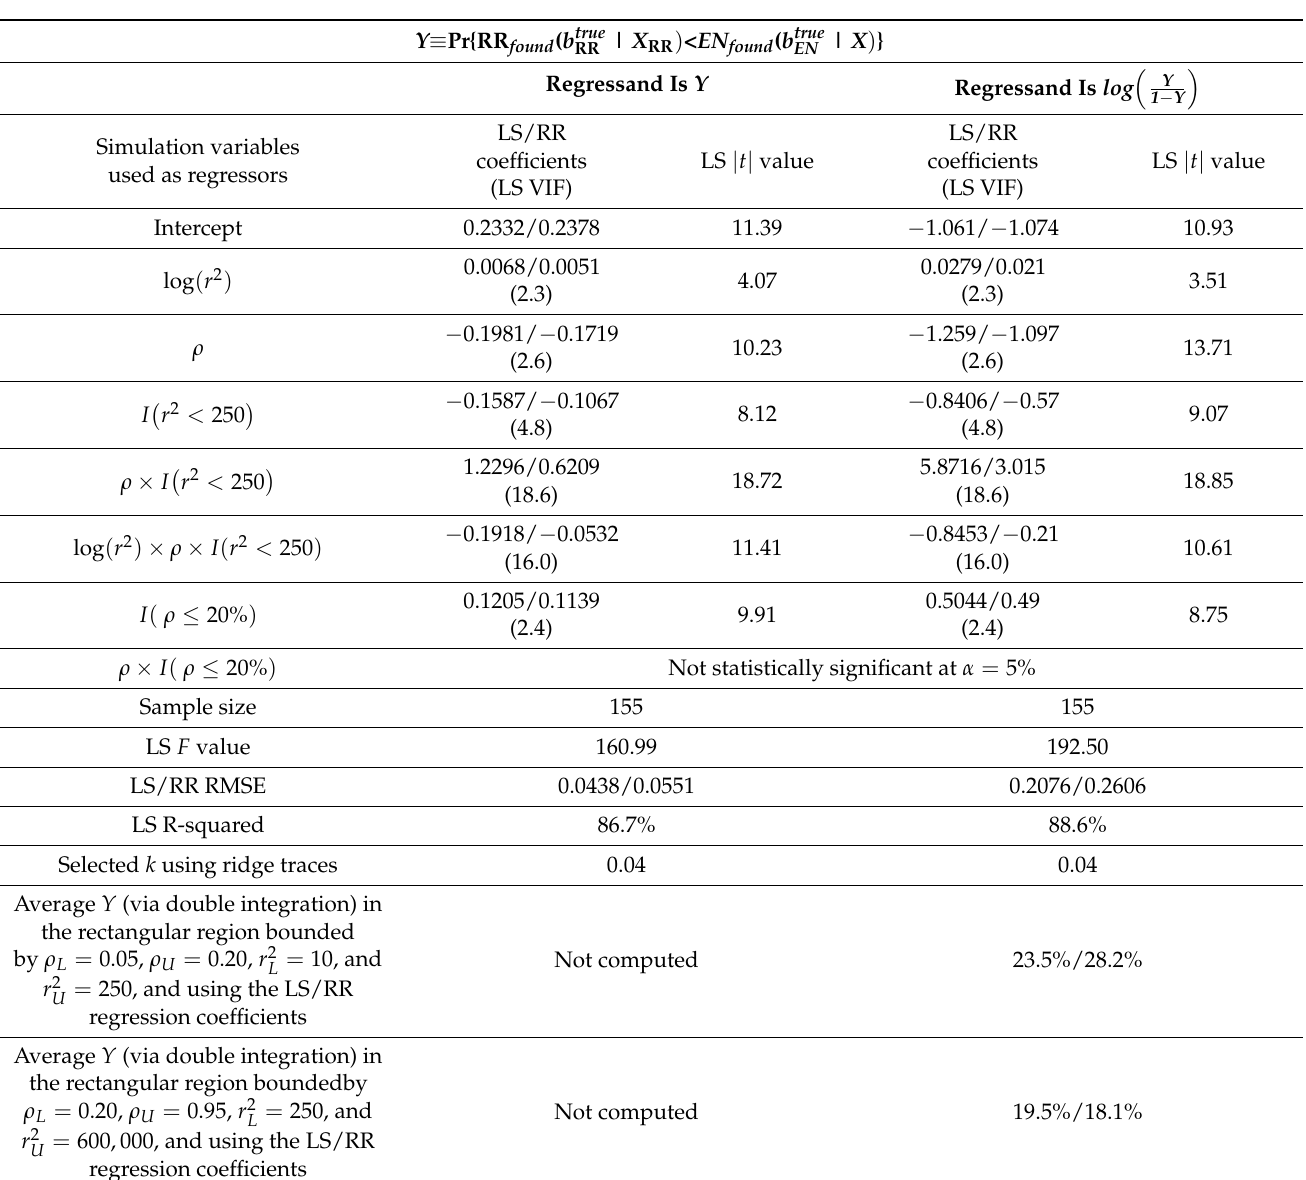
Table 4. Approximating patterns in simulated miss rates, ω ∼ =